Question: Sum up the contents of this chart in one sentence.
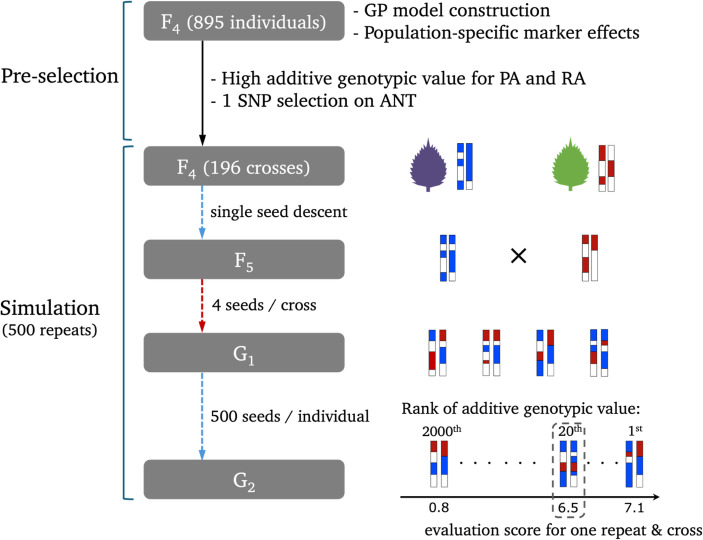
Answer: Workflow of the simulation for cross selection based on predicted progeny performance. To reduce computation time, pre-selection was performed on the F₄ generation, and simulations were conducted for 196 selected cross pairs using the F₄ genotypic data. The schematic on the right illustrates the conceptual flow of the simulation process for one cross and one replication